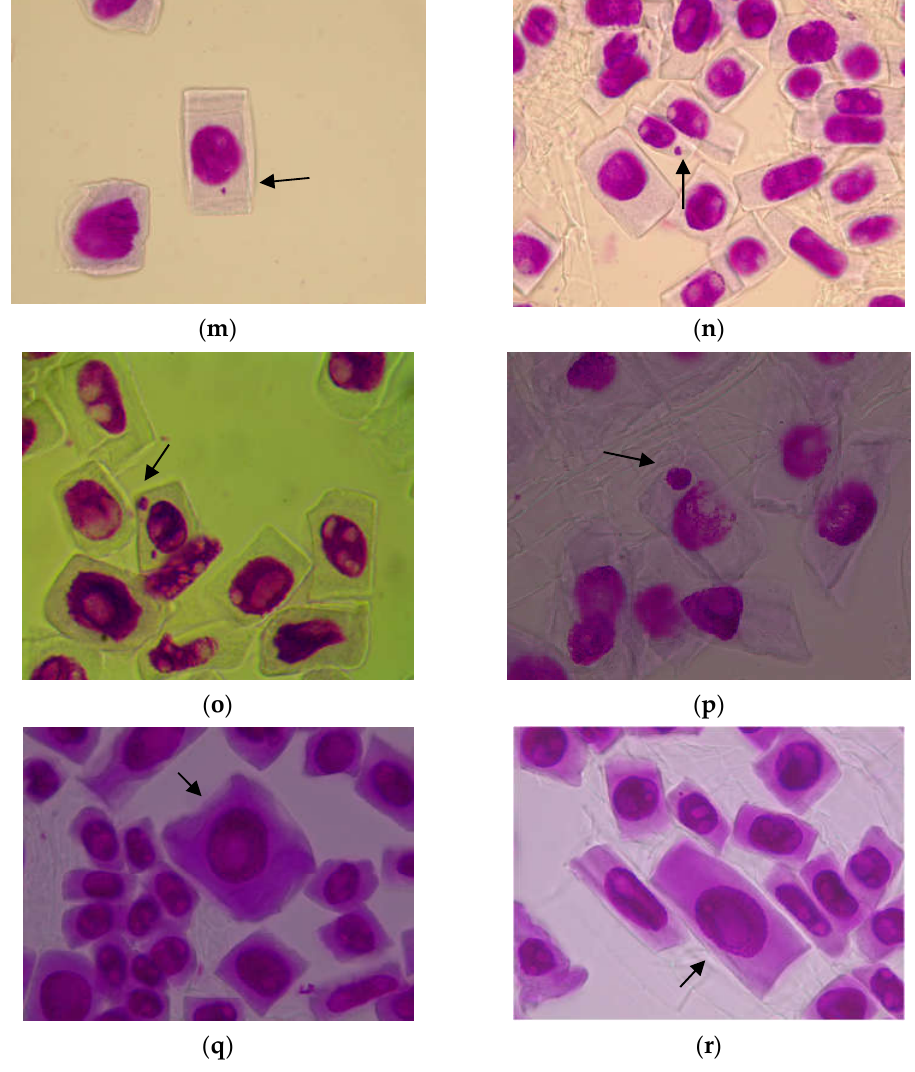
Figure 6. Types of genetic abnormalities induced by non-thermal plasma-activated water identified in Triticum aestivum root meristems: ( a ) c–metaphase; ( b ) sticky chromosomes in metaphase; ( c ) anaphase with a thin and whole bridge; ( d ) telophase with whole and broken bridges; ( e ) telophase with a laggard chromosome and a broken bridge; ( f ) telophase with a broken bridge and chromosomal fragments; ( g ) telophase with a whole bridge; ( h ) sticky chromosomes in telophase:multiple whole and broken bridges; ( i ) early telophase with a chromosomal fragment; ( j ) sticky chromosomes in multipolar ana-telophase: a whole bridge and a broken one;( k ) two telophases with whole and broken multiple bridges; ( l ) telophase with a thin, whole bridge; ( m ) interphase with a very small micronucleus; ( n ) interphase with a medium-sized micronucleus; ( o ) interphases with two micronuclei of different sizes; ( p ) interphase with a large micronucleus; ( q , r ) autopolyploid giant nuclei; the microphotographs ( a – g , i , k , o ) were taken with an Oxion microscope; the microphotographs ( h , j , l – n , p – r ) were taken with a Leica microscope (magnification: 1000 ×